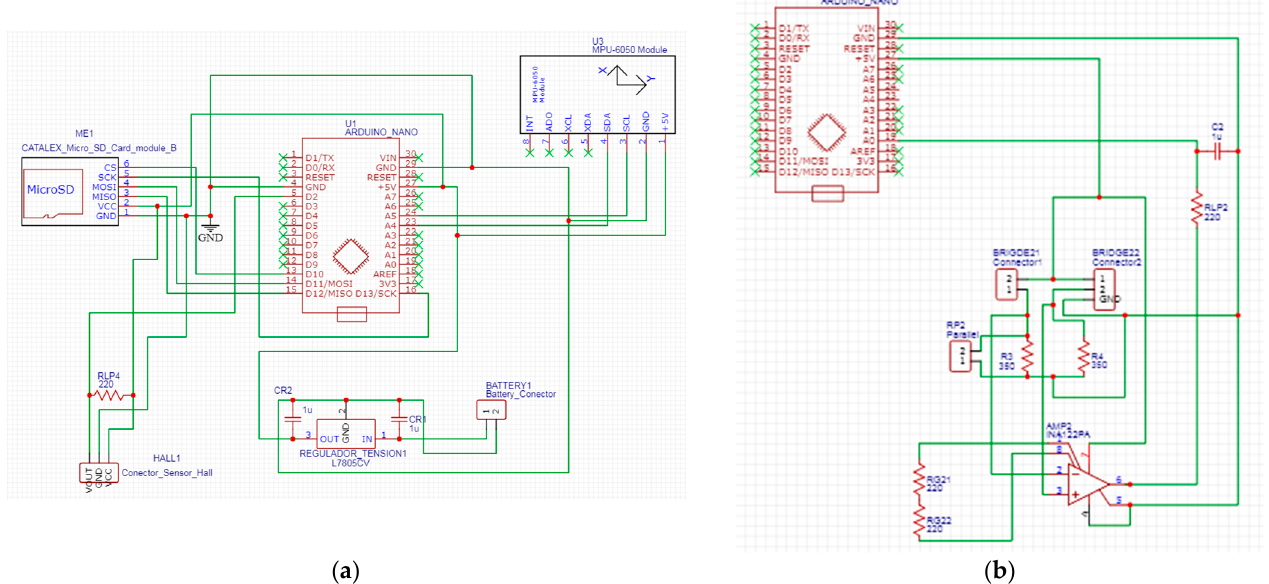
Figure 6. Diagram of the elements used in the PCB. ( a ) Power supply and data storage circuit with voltage regulator. ( b ) Half-Wheatstone bridge measurement circuit with low-pass filter. Table 1. Microdeformations measured by the gauges when applying a force of 98.1 N in each direc- tion.